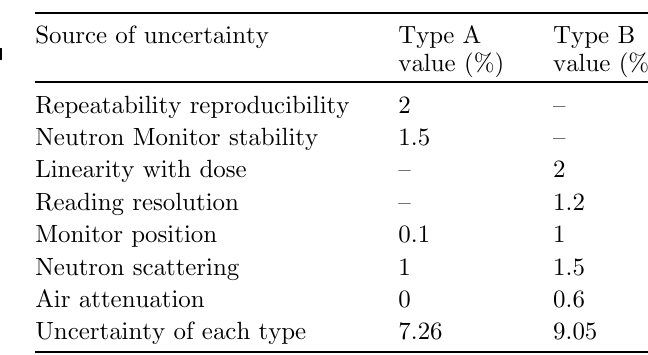
Table 1. The uncertainty budget in the measured